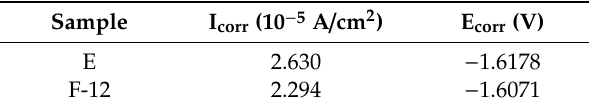
Figure 9. Polarization curves of the alloy. Table 4. Corrosion properties of the alloy.